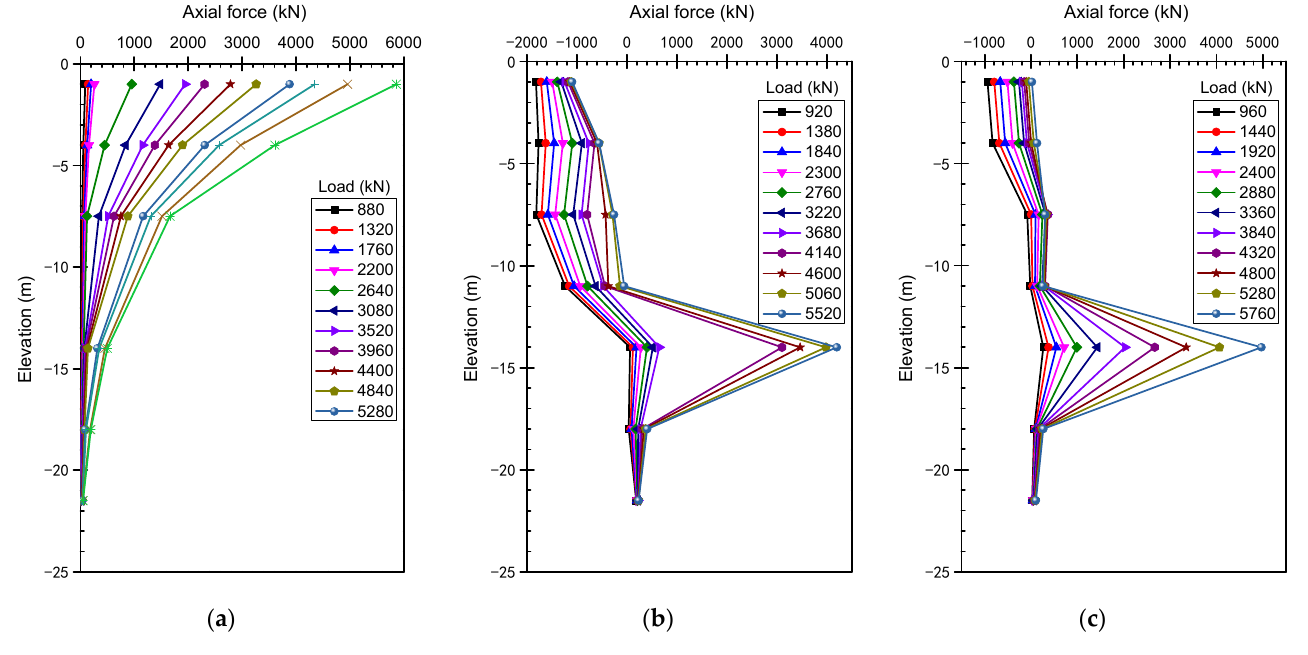
Figure 6. Distribution of axial force of test pile: (a) KB1; (b) KB2; (c) KB7. Table 3. Lateral friction resistance of piles under the load of 5520 kN.